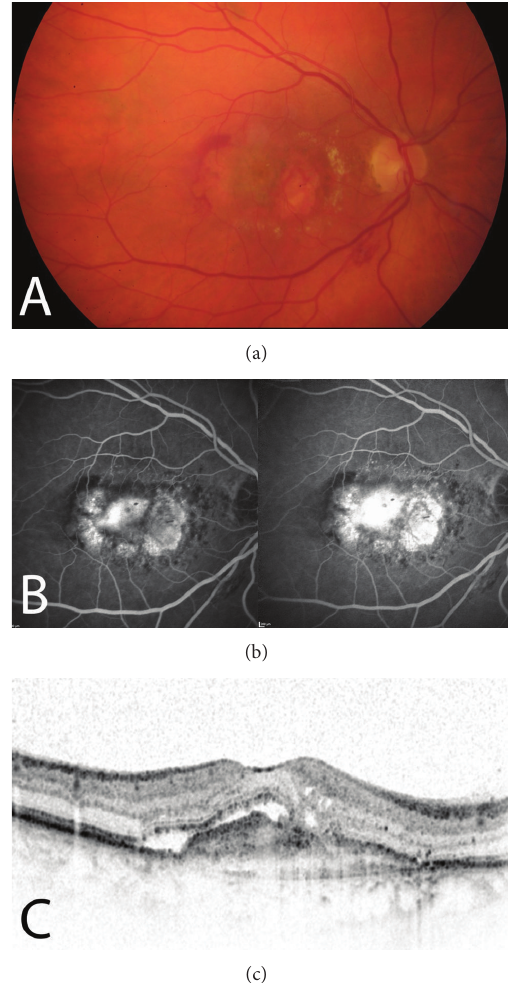
Figure 1: Eye with active CNV. Color fundus photography (a) dem- onstrates hemorrhage and fibrovascular tissue, fluorescein angiog- raphy (b) shows classic and occult CNV leakage, and SDOCT (c) presents intraretinal cystoid spaces, subretinal fluid, subretinal hyperreflective material, and a pigment epithelial